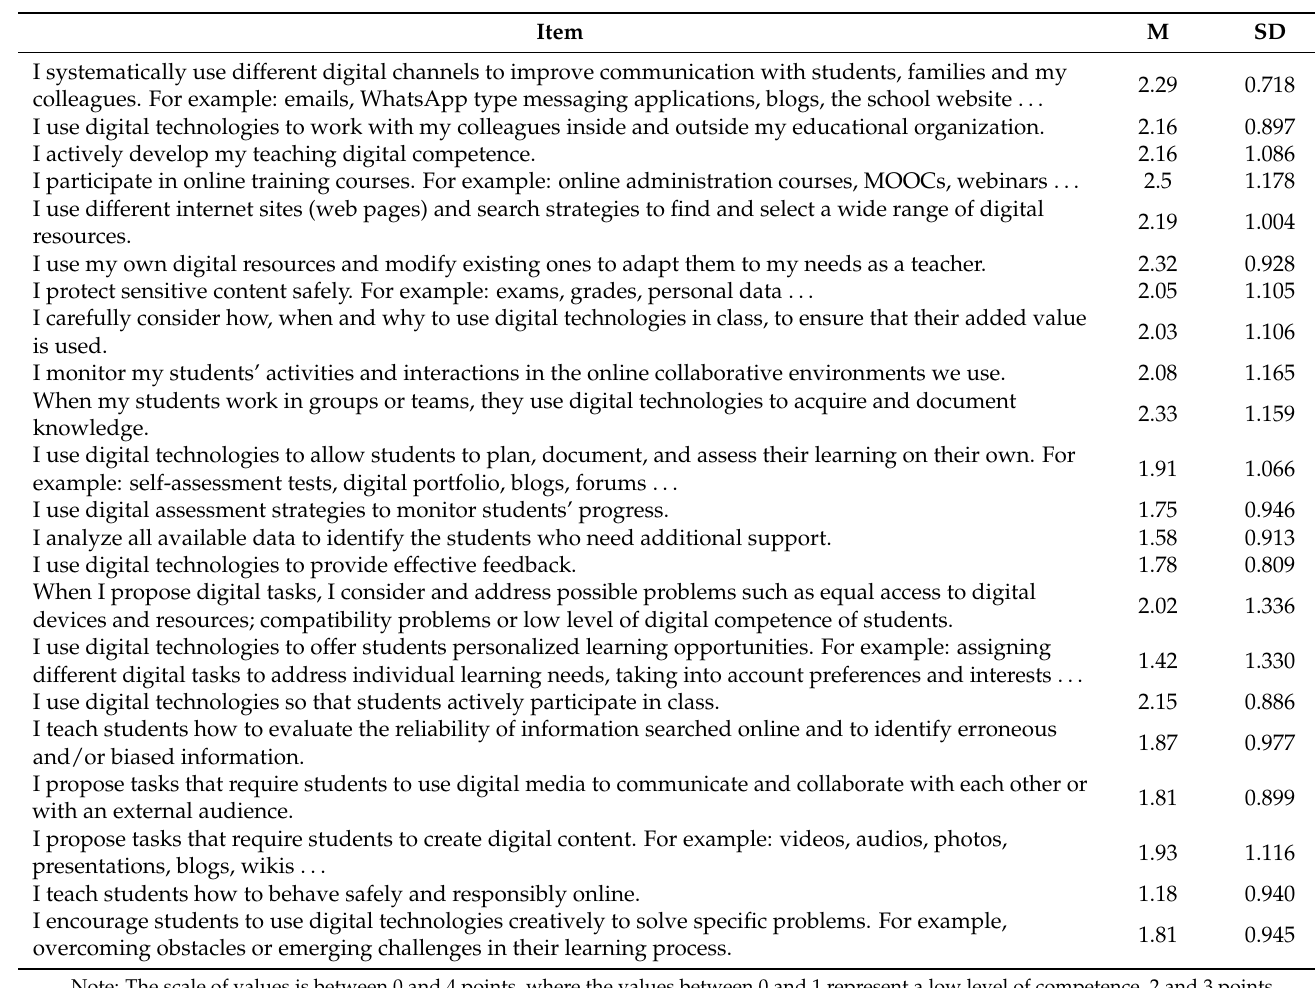
Table 4. Mean and standard deviation of DigCompEdu